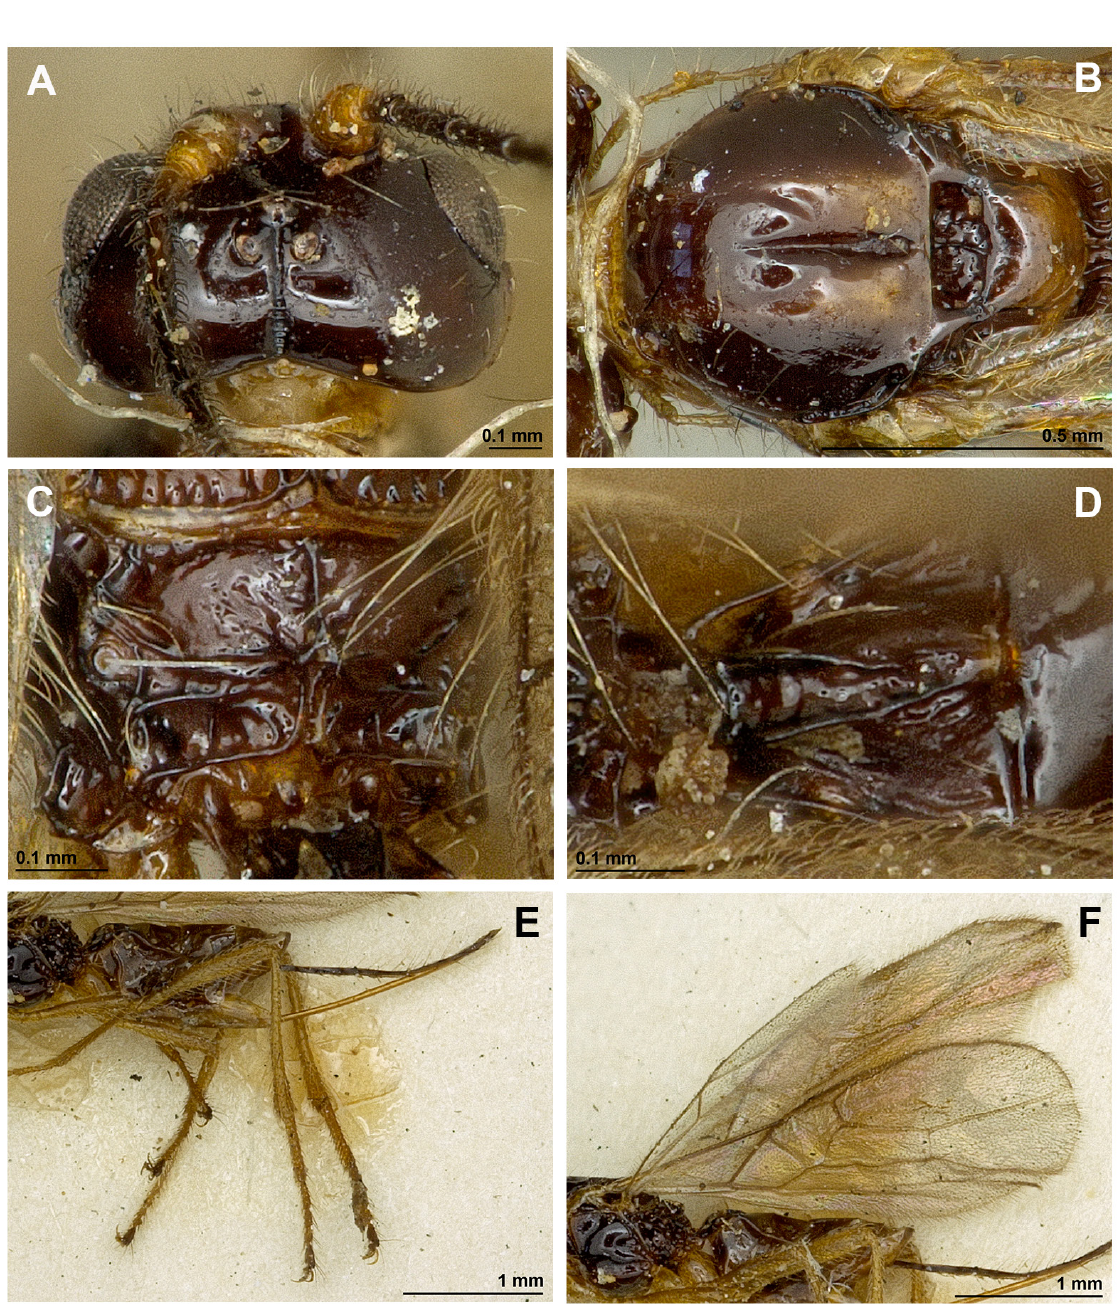
Fig. 2. Asobara abyssiniaensis Peris-Felipo, sp. nov., ♀, holotype (BMNH 459). A . Head, dorsal view. B . Mesoscutum, dorsal view. C . Propodeum, dorsal view. D . First metasomal tergite, dorsal view. E . Hind leg, metasoma and ovipositor, lateral view. F . Fore and hind